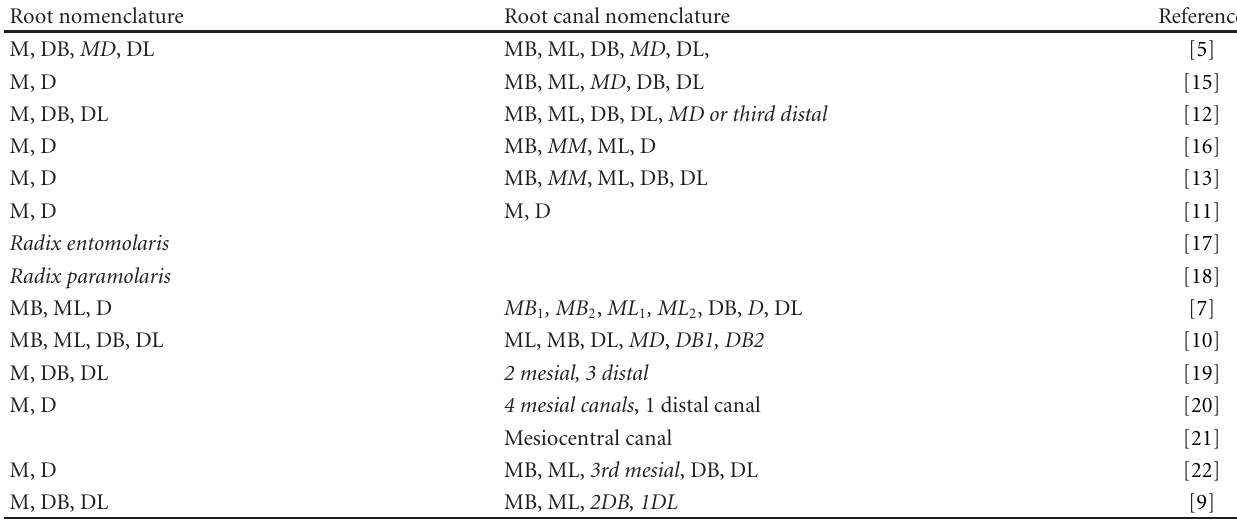
Table 1: Table summarizing the variations of roots and the canal anatomy of mandibular molars, as reported by various authors, with the numerous terms that have been used to name these